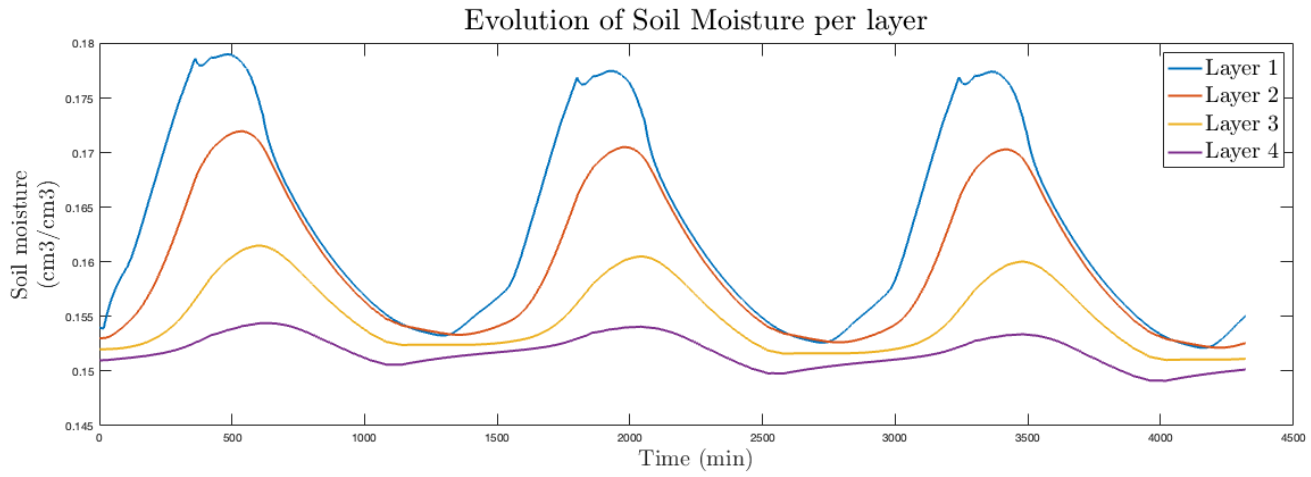
Figure 8. Soil moisture dynamics per soil layer for the predictive controller (RTO + MPC) irrigation